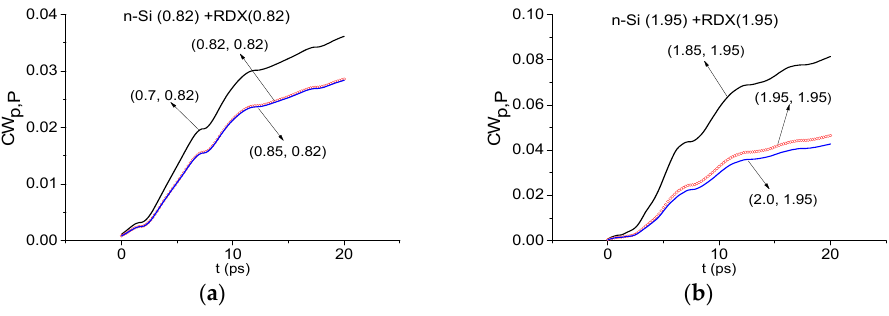
Figure 11. Integral characteristics CW p,P ( t n ) calculated for the frequencies ν = 0.82 THz ( a ); 1.95 THz ( b ) THz for n-Si signal with RDX_Air as a standard one.